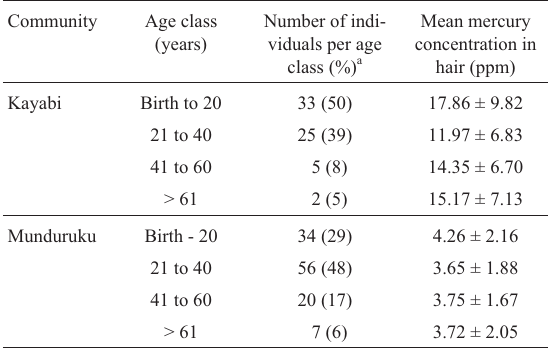
Table 1 - Mercury levels in hair from individuals from the Kayabi and Munduruku communities